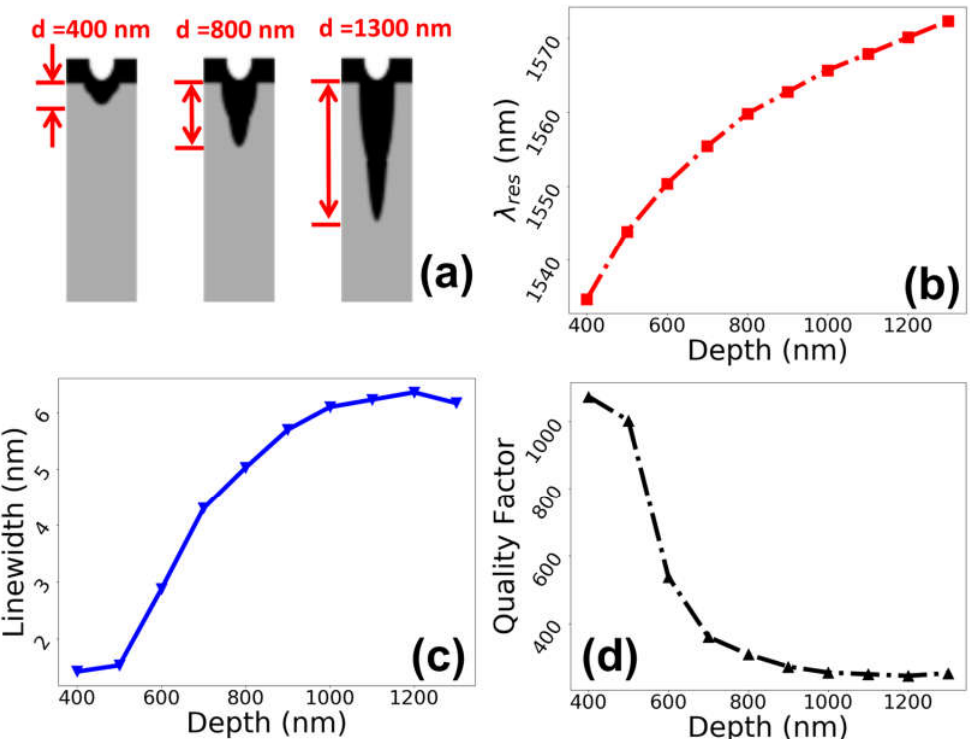
Figure 7. ( a ) Cross-sectional view of the simulation model with hole-depth values of d = 400, 800, and 1300 nm. ( b )   vs. hole-depth. ( c ) Linewidth vs. hole-depth. ( d ) QF vs. hole-depth. and 1300 nm. ( b ) λ res vs. hole-depth. ( c ) Linewidth vs. hole-depth. ( d ) QF vs.